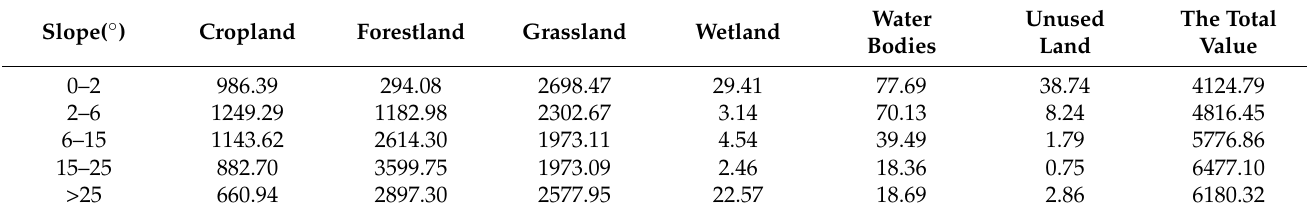
Table 7. ESV per unit area of different slope levels. Unit: CNY/hm 2 .